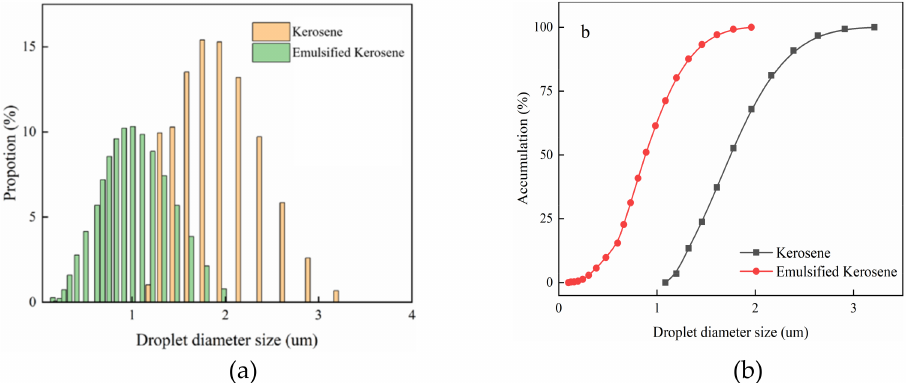
Figure 10. Size distribution of oil droplet (kerosene vs emulsified kerosene) ( a ) the size probability distribution; ( b ) the size cumulative distribution.